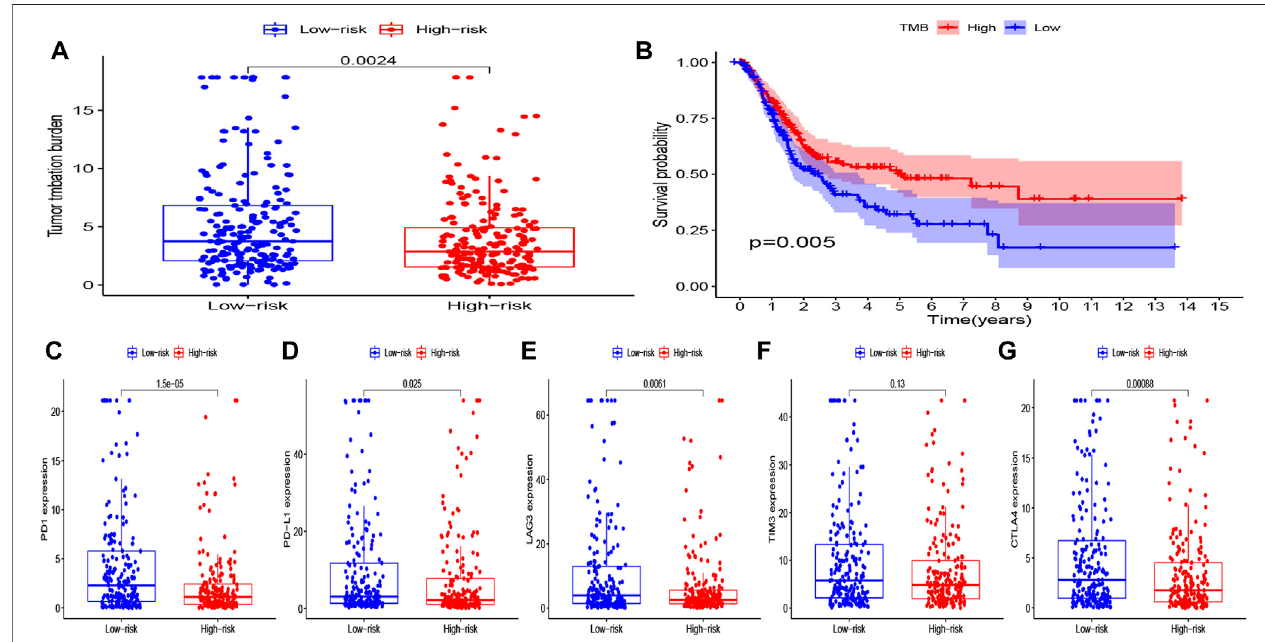
FIGURE9|(A) LevelofTMBinthehigh-andlow-riskgroups. (B) Kaplan – MeiercurvesofOSforthehigh-andlow-TMBgroups(P=0.005). (C – G) Levelofimmune checkpoints (PD1, PD-L1, TIM3, LAG3, and CTLA4) in the high- and low-risk groups.